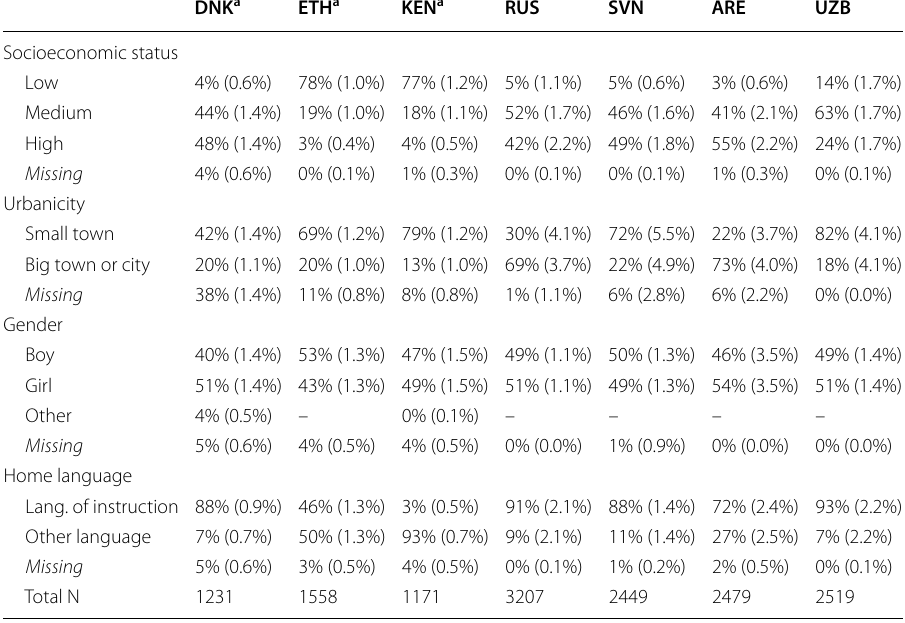
Table 3 Overview statistics of students by